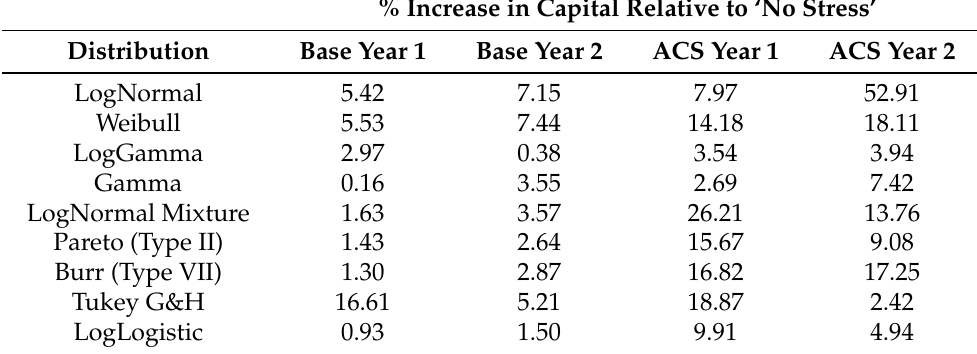
Table 4. One- and two-year percentage changes in capital relative to “no stress” using the base and ACS economic scenarios with nonCPBP data. The percentage changes indicate increasing capital from year to year, and greater increases for strong economic stress (ACS) relative to mild stress (Base). % Increase in Capital Relative to ‘No